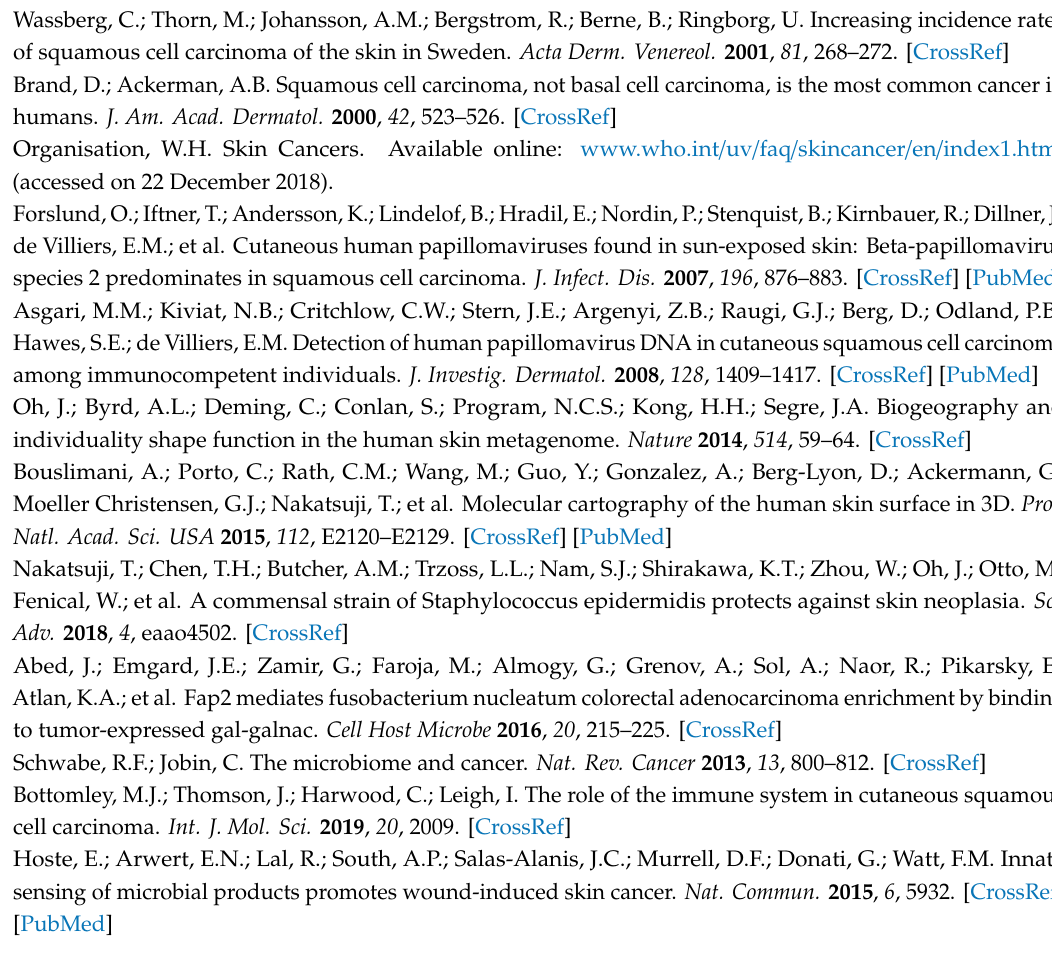
Di ff erential abundant taxa in keratinocyte tumors (log(10)-transformed read data), Figure S5: LEfSe bar-chart output (keratinocyte tumors), Figure S6: LEfSe output as in Figure 2H with higher magnification, Figure S7: LEfSe bar-chart output (keratinocyte tumors and healthy skin), Figure S8: LEfSe output as in Figure S3GH with higher magnification, Figure S9: Heat map representation of dominant taxa revealed by unsupervised hierarchical clustering, Figure S10: Significant increase of S. aureus loads in SCC compared to its adjacent non-lesional skin, Figure S11: qPCR (bacterial load, Staphylococcus and S. aureus loads) including psoriasis samples, Figure S12: CFU plating of S. aureus strains after co-culture, Figure S13: Viable cells, apoptosis, and necrosis assay by flow-cytometry, Figure S14: Optimization of DNA extraction out of FFPE specimens, Figure S15: Specificity testing of the S. aureus -specific FISH probe, Figure S16: Scheme indicating the proposed model of SCC tumorigenesis, Batch file: Batch file specifying microbiota analysis